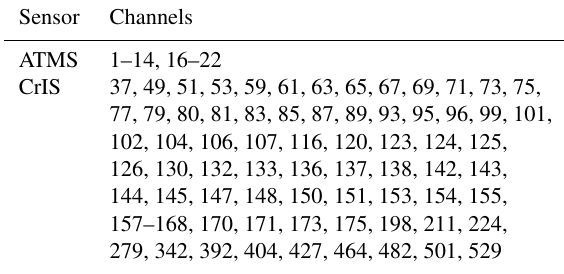
Table 1. The channels for ATMS and CrIS data that have been se- lected for the data assimilation